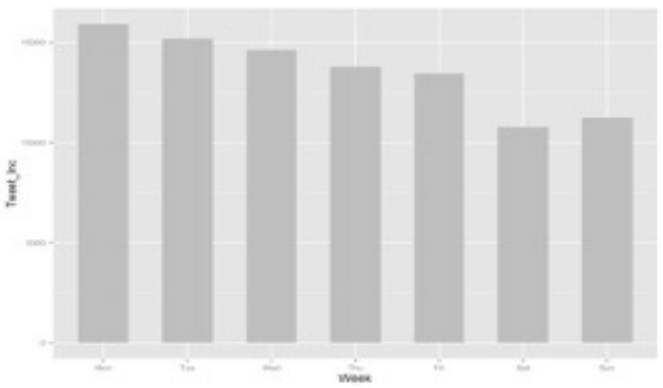
Figure 3. The weekly distribution of postings that include the term MOOC on Sina Weibo. Contributing postings after